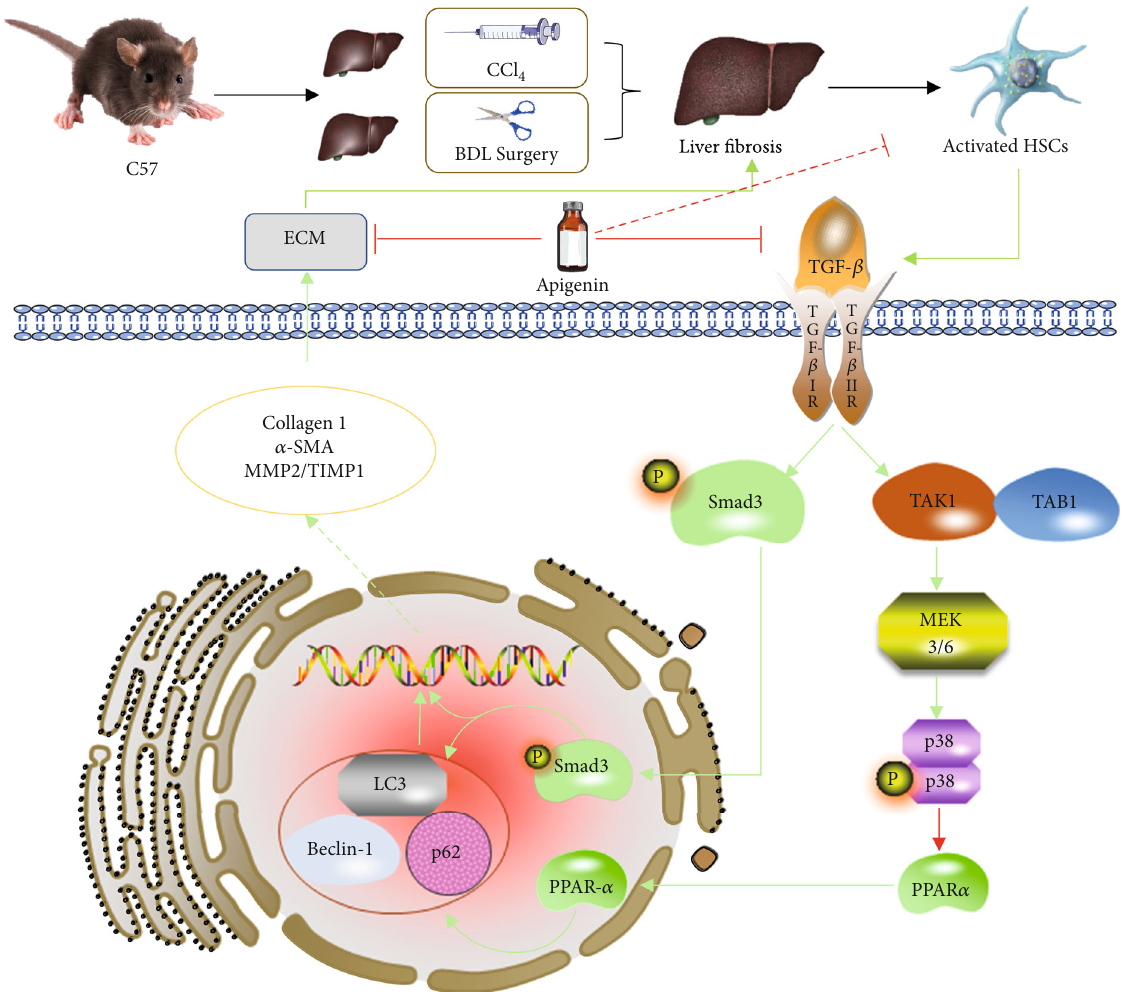
Figure 6: Probable mechanisms of apigenin against liver fi brosis. Notes: apigenin inhibits the production of TGF- β 1 in HSCs. The decrease of TGF- β 1 results in the reduced activation of HSCs and downregulation of the TGF- β 1/Smad3 and p38/PPAR α signaling pathway, including decreased ECM production and inhibition of autophagy. Abbreviations: BDL: bile duct ligation; CCl extracellular matrix; HSCs: hepatic stellate